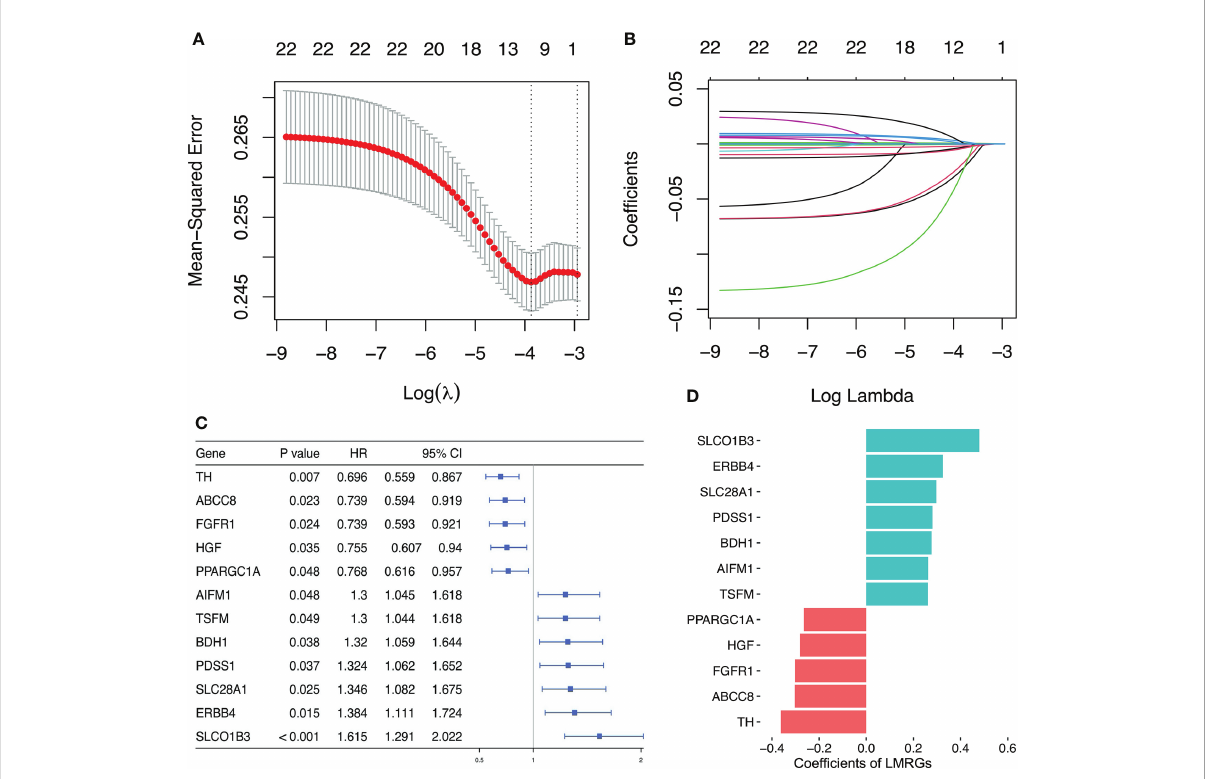
FIGURE 3 Establishment of lactate metabolism-related prognostic risk signature. (A) Screening of optimal l value in LASSO model at which the vertical lines were drawn. (B) LASSO coef fi cient pro fi les of the 22 LMRGs with non-zero coef fi cients determined by the optimal l value. (C) Multivariate cox analysis to developing a prognostic signature based on these LMRGs. (D) Coef fi cients of the 12